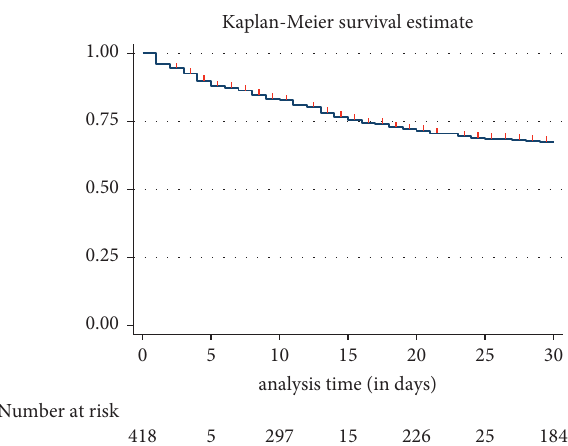
Figure 1: Kaplan–Meier graph showing the probability of survival of CKD V patients with COVID-19 ( n � 418). Figure 2: Kaplan–Meier graph showing the probability of survival of CKD V patients with COVID-19 by group ( n �